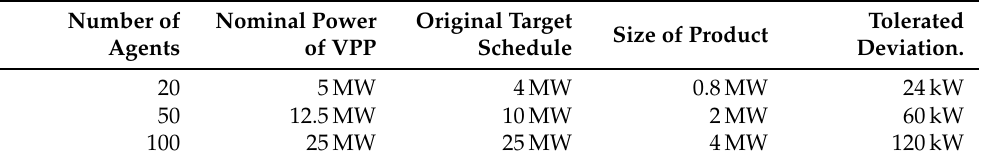
Table 2. Experiment setup for varying VPP sizes. The number of agents scales with the total nominal power of the virtual power plant (VPP), as well as the original target schedule and the allowed deviation. Tolerated Number of Nominal Power Original Target Size of Product Deviation. Agents of VPP Schedule 20 5MW 4MW 0.8MW 24kW 50 12.5MW 10MW 2MW 60kW 100 25MW 25MW 4MW 120kW